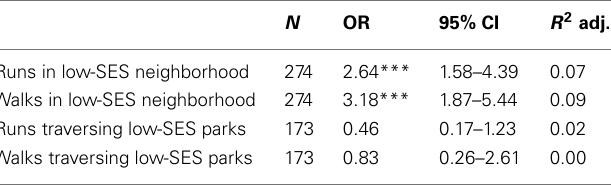
Table 2 | Logistic regression: odds of running and walking in a low-SES neighborhood and park, compared to higher-SES neighborhoods in St. Louis, MO, USA in 2012 . N OR 95% CI R 2 adj. Runs in low-SES neighborhood 274 2.64*** 0.07 Walks in low-SES neighborhood 274 3.18*** 173 0.46 173